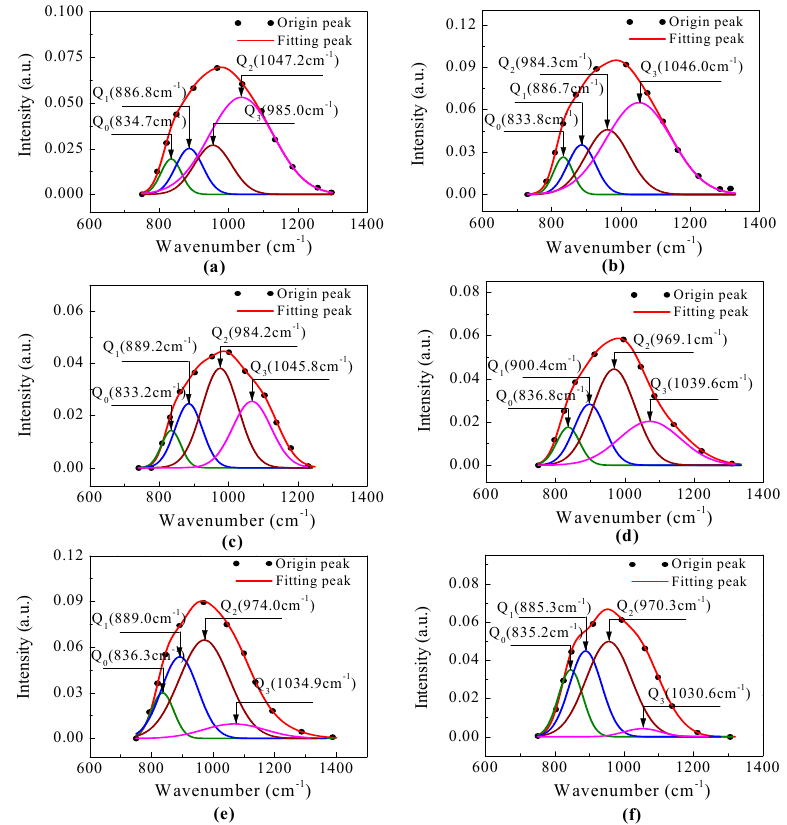
Figure 6. FTIR spectra of smelting slag with the various ω (MgO)/ ω (Al 2 O 3 ) ratios. Figure 7 shows the peak division results of the FTIR with different ω (MgO)/ ω (Al 2 O 3 ) ratios in the wavenumber range of 1200–800 cm − 1 . The peak center position corresponding to each tetrahedral structure increased, and the wavenumber corresponding to the peak center positions of the Q 0 and Q 1 structures (834.7 and 886.8 cm − 1 , respectively) did not change significantly. The peaks corresponding to the Q 2 and Q 3 structures gradually moved to the low wavenumber region, decreasing from 985.0 to 970.3 cm − 1 and from 1047.2 to 1030.6 cm − 1 , respectively. This shows that the stability of the Q 2 and Q 3 structural units in the slag structure decreased with the increase of the ω (MgO)/ ω (Al 2 O 3 ) ratio and tended to simplify in structure.